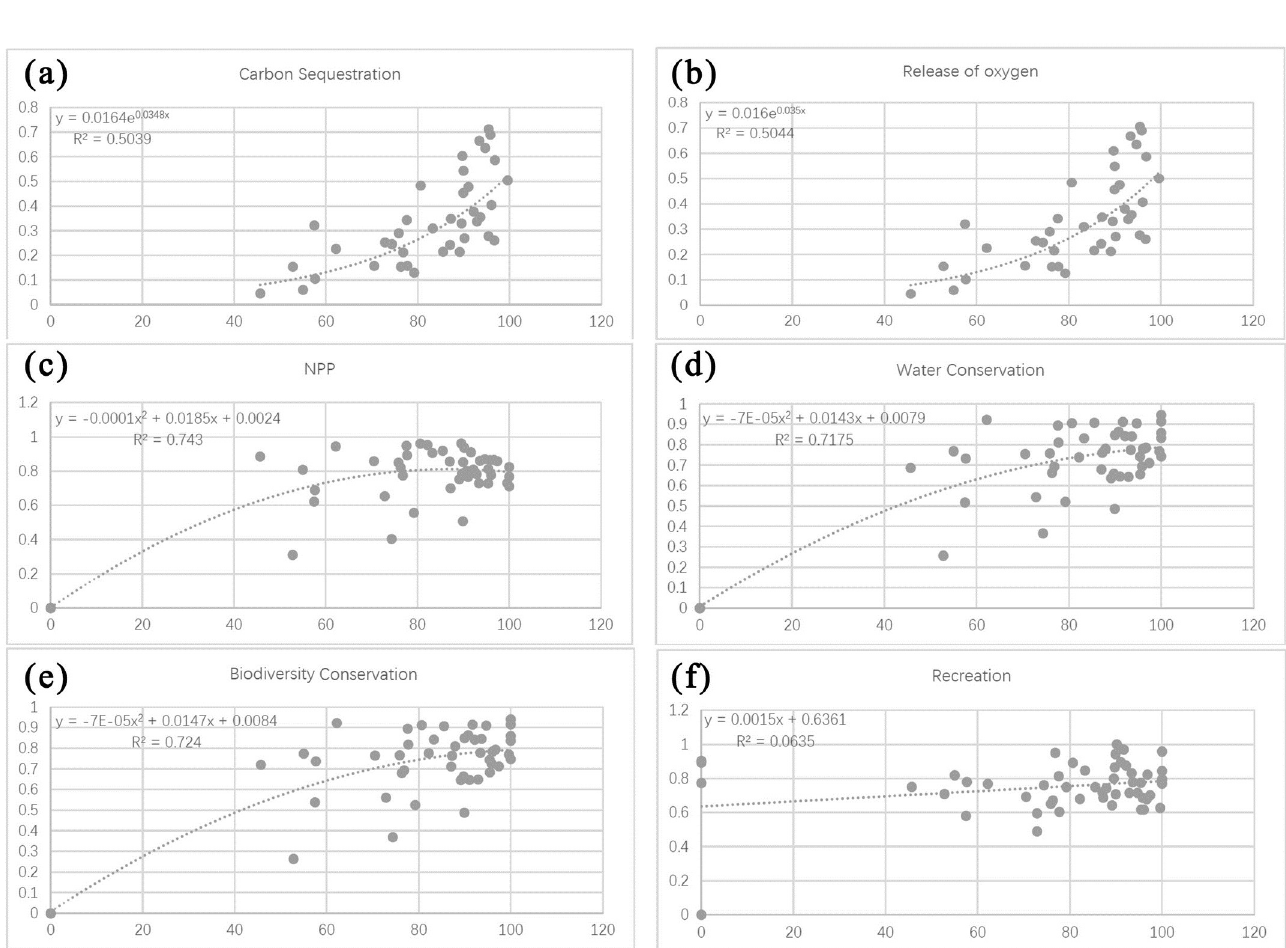
Fig 8. Relationships between the forest landscape percentage index (PLAND) and four ecosystem service functions. Plots show the relationship between PLAND and (a) carbon sequestration capacity, (b) oxygen release capacity, (c) NPP capacity, (d) water conservation capacity, (e) biodiversity conservation capacity, and (f) recreation